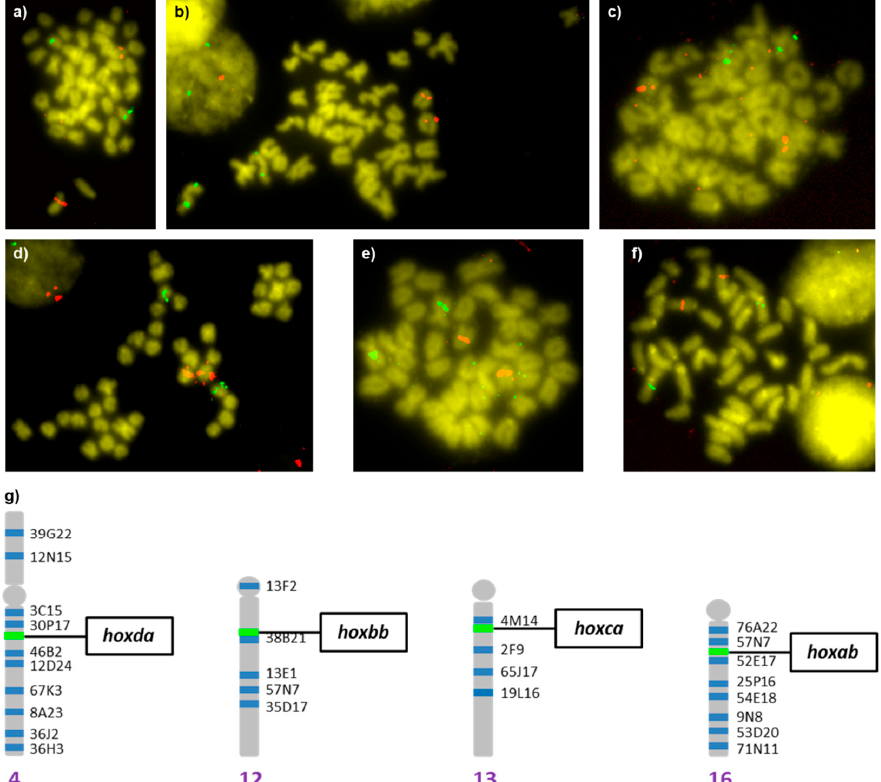
Figure 4. BAC-FISH among the hox -bearing BAC clones: ( a ) hoxab (red)— hoxbb (green); ( b ) hoxab (red)— hoxca (green); ( c ) hoxbb (red)— hoxda (green); ( d ) hoxbb (green)— hoxca (red); ( e ) hoxab (red)— hoxda (green); ( f ) hoxca (red)— hoxda (green); and ( g ) schematic representation of the localization within the cytogenetic map of Solea senegalensis (extracted from [17]).